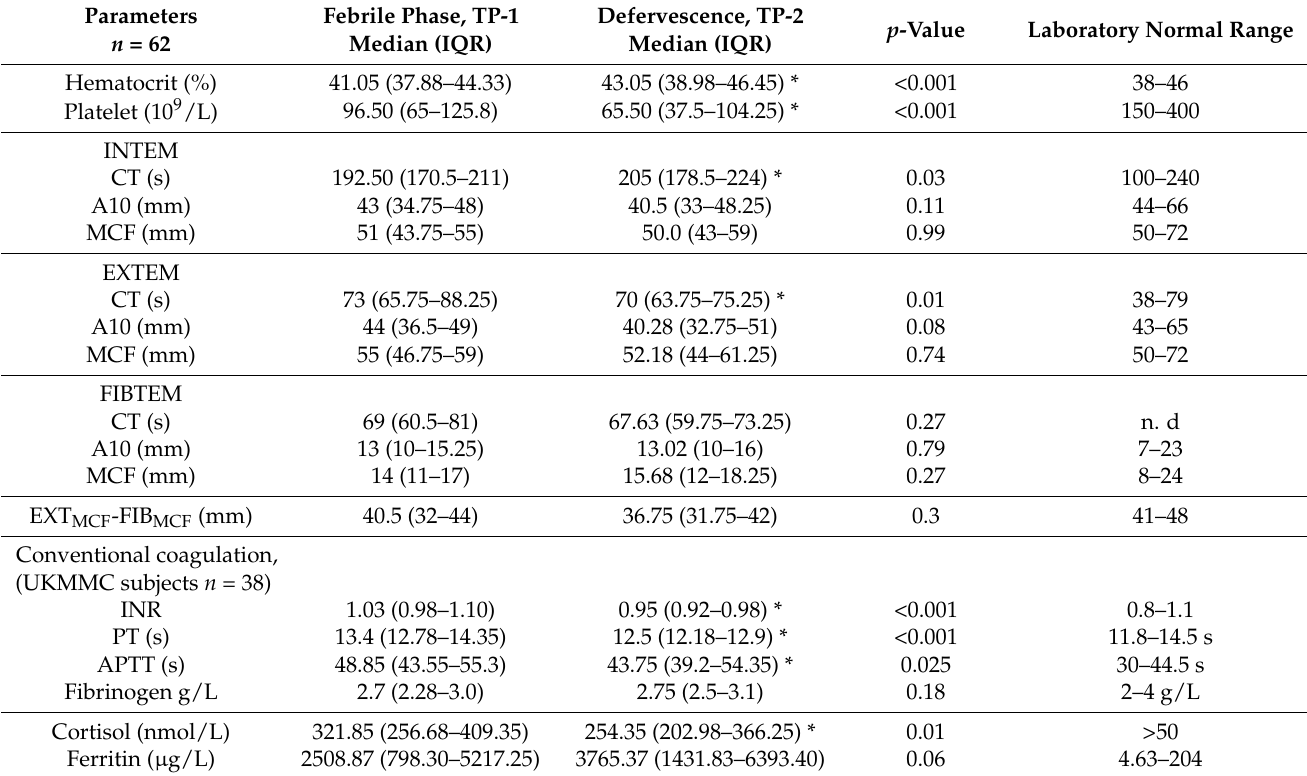
Table 5. The kinetics of hemostatic and biochemical markers in dengue with warning signs between febrile phase and